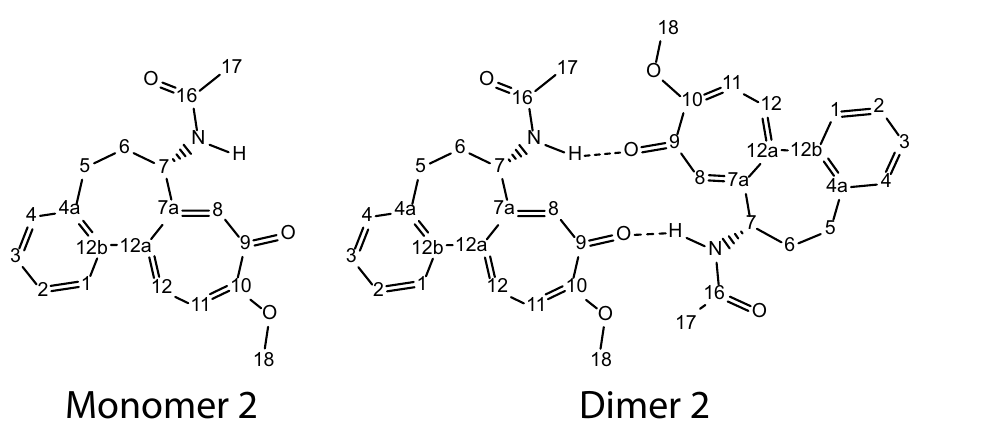
Figure 3. The partial structure of colchicine molecule used for DFT calculations.